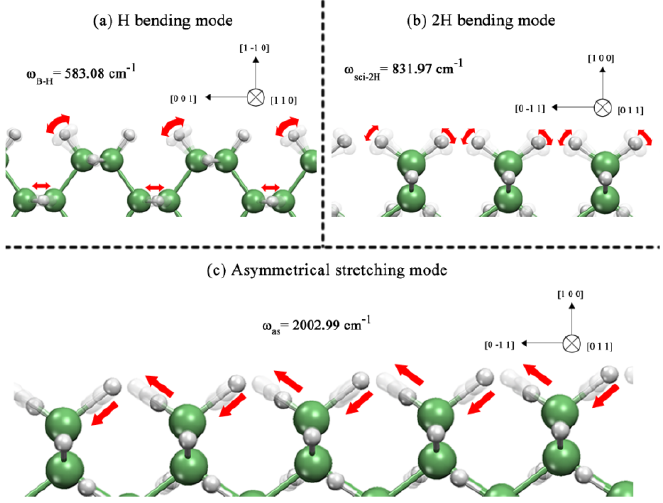
) and ( c ) dihydride asymmetrical stretching mode (  2 sci H 